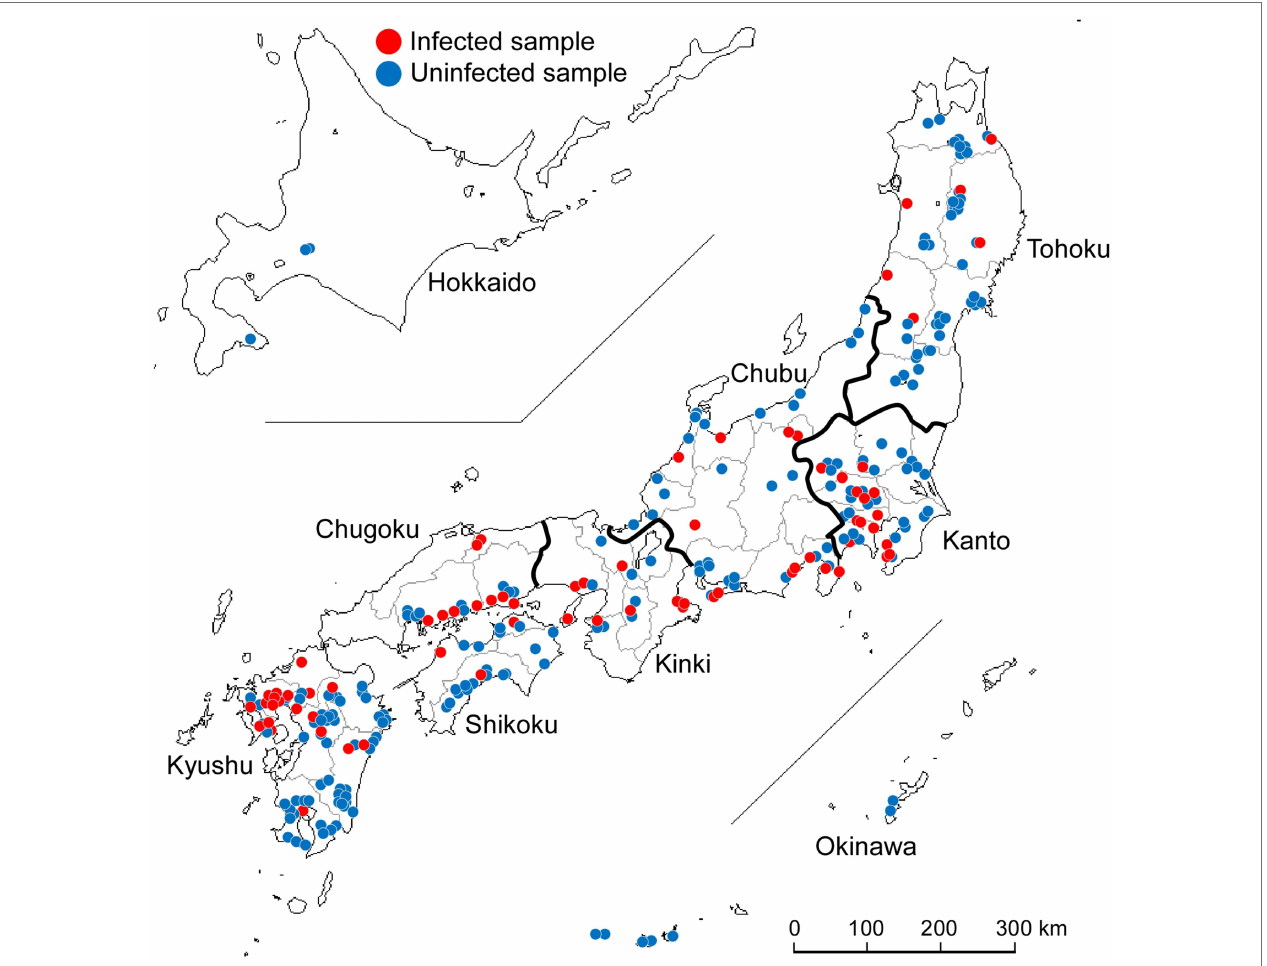
FIGURE 1 | Collection of wild Japanese garlic ( Allium macrostemon Bunge) plants showing striped and asymptomatic leaves from different sites in Japan during 2012–2015. The map was obtained from